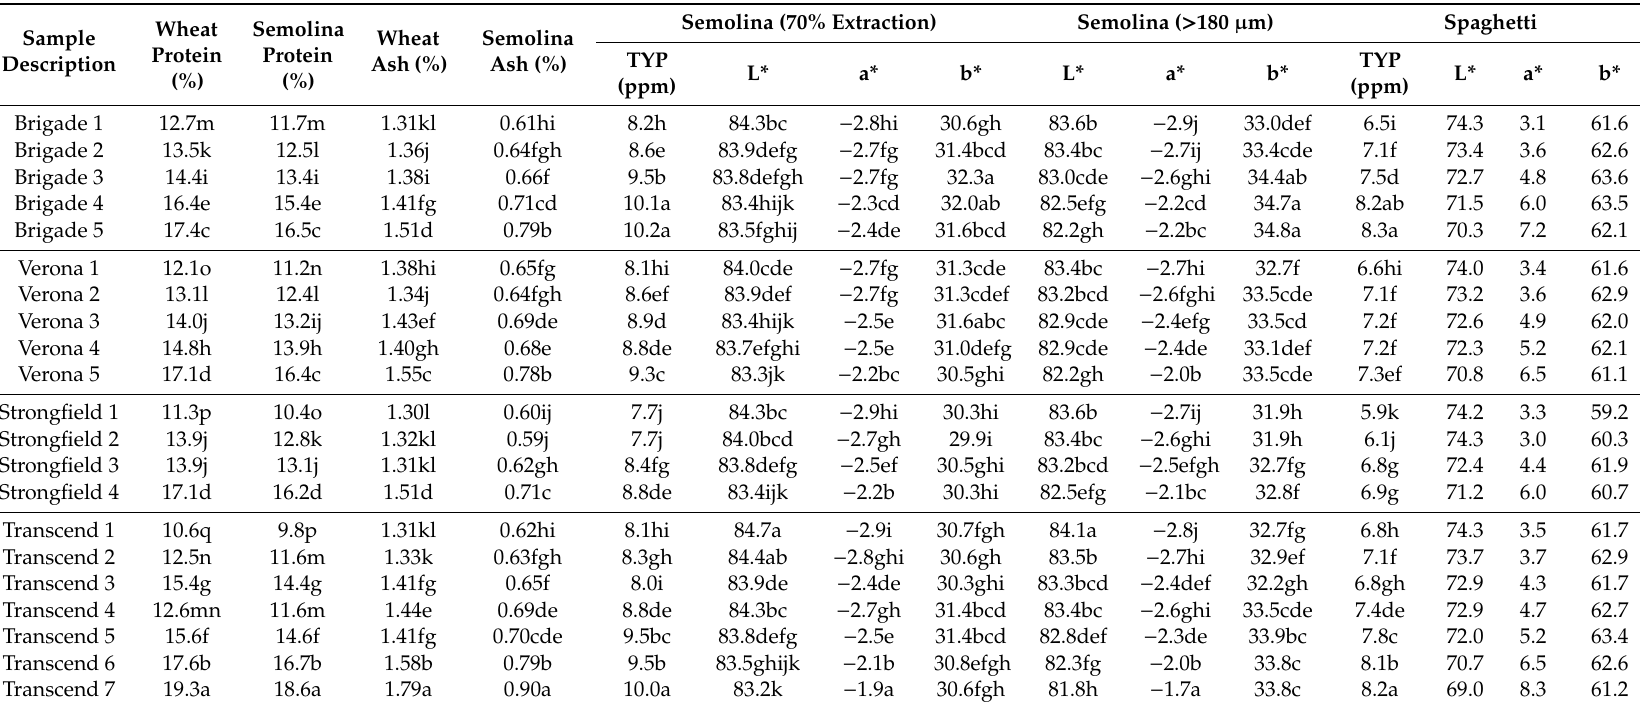
Table 5. Semolina and spaghetti color characteristics of varietal composites prepared from 2017 harvest